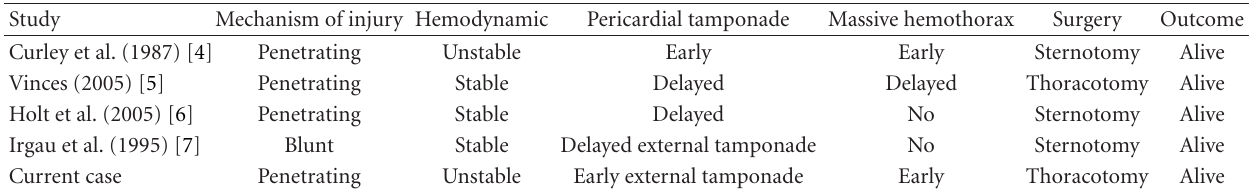
Table 1: Review of literature of internal mammary artery injuries.